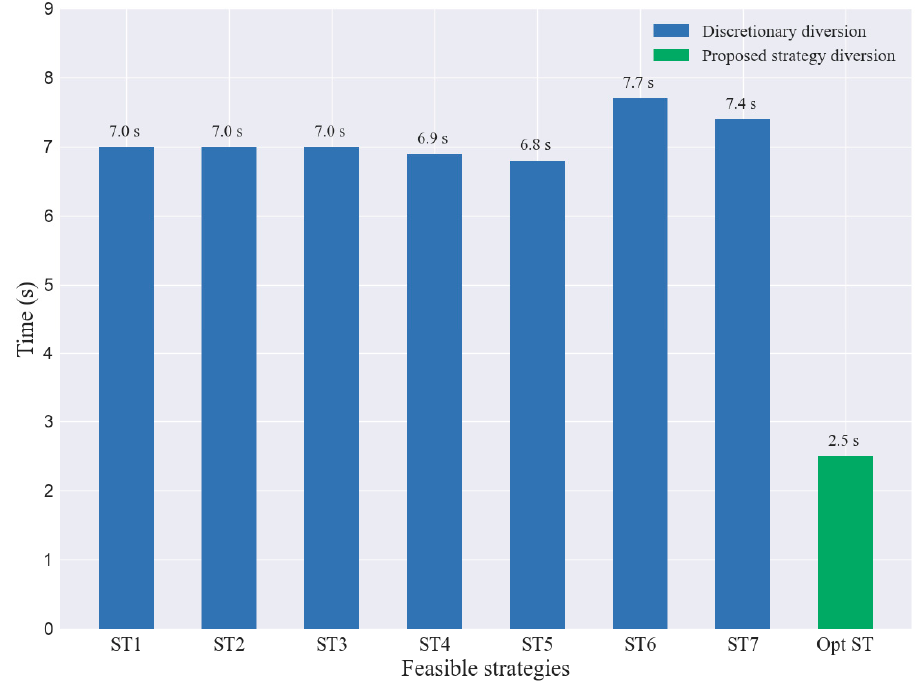
Figure 13. Comparison of loss time of feasible strategies.